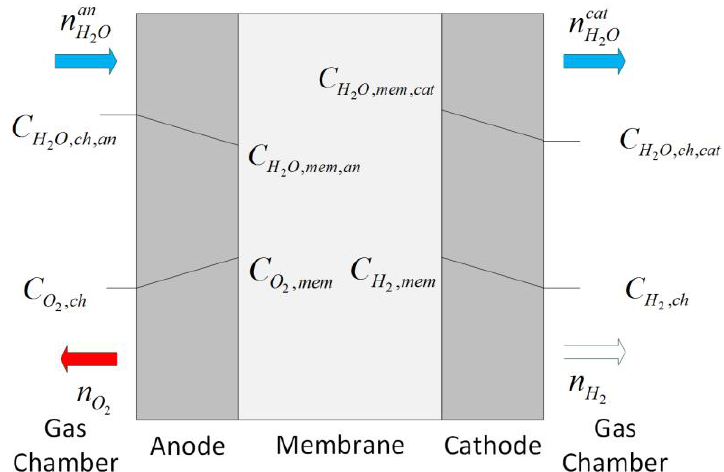
Figure 3. Species concentration inside the membrane and in the reactant channels (adapted from [8]).